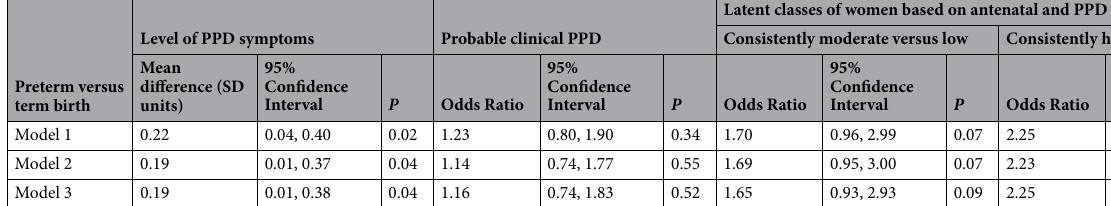
Table 2. Associations between preterm versus term birth and maternal postpartum depressive symptoms (PPD). Model 1 is unadjusted; Model 2 is adjusted for maternal age at delivery, maternal education, maternal smoking and/or alcohol use at any time during pregnancy, delivery mode and child sex; Model 3 is a sensitivity analyses: Model 2 where women with mood disorder diagnoses before childbirth are excluded.